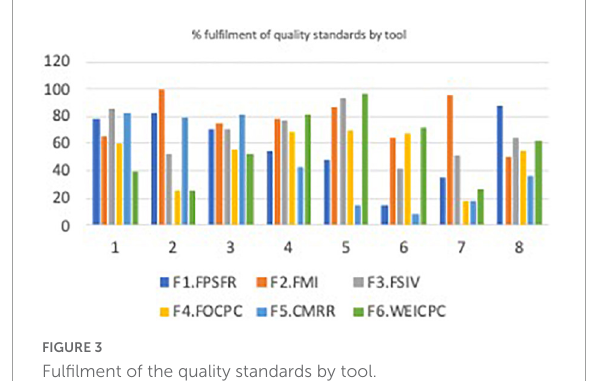
FIGURE3 Fulfilment of the quality standards by